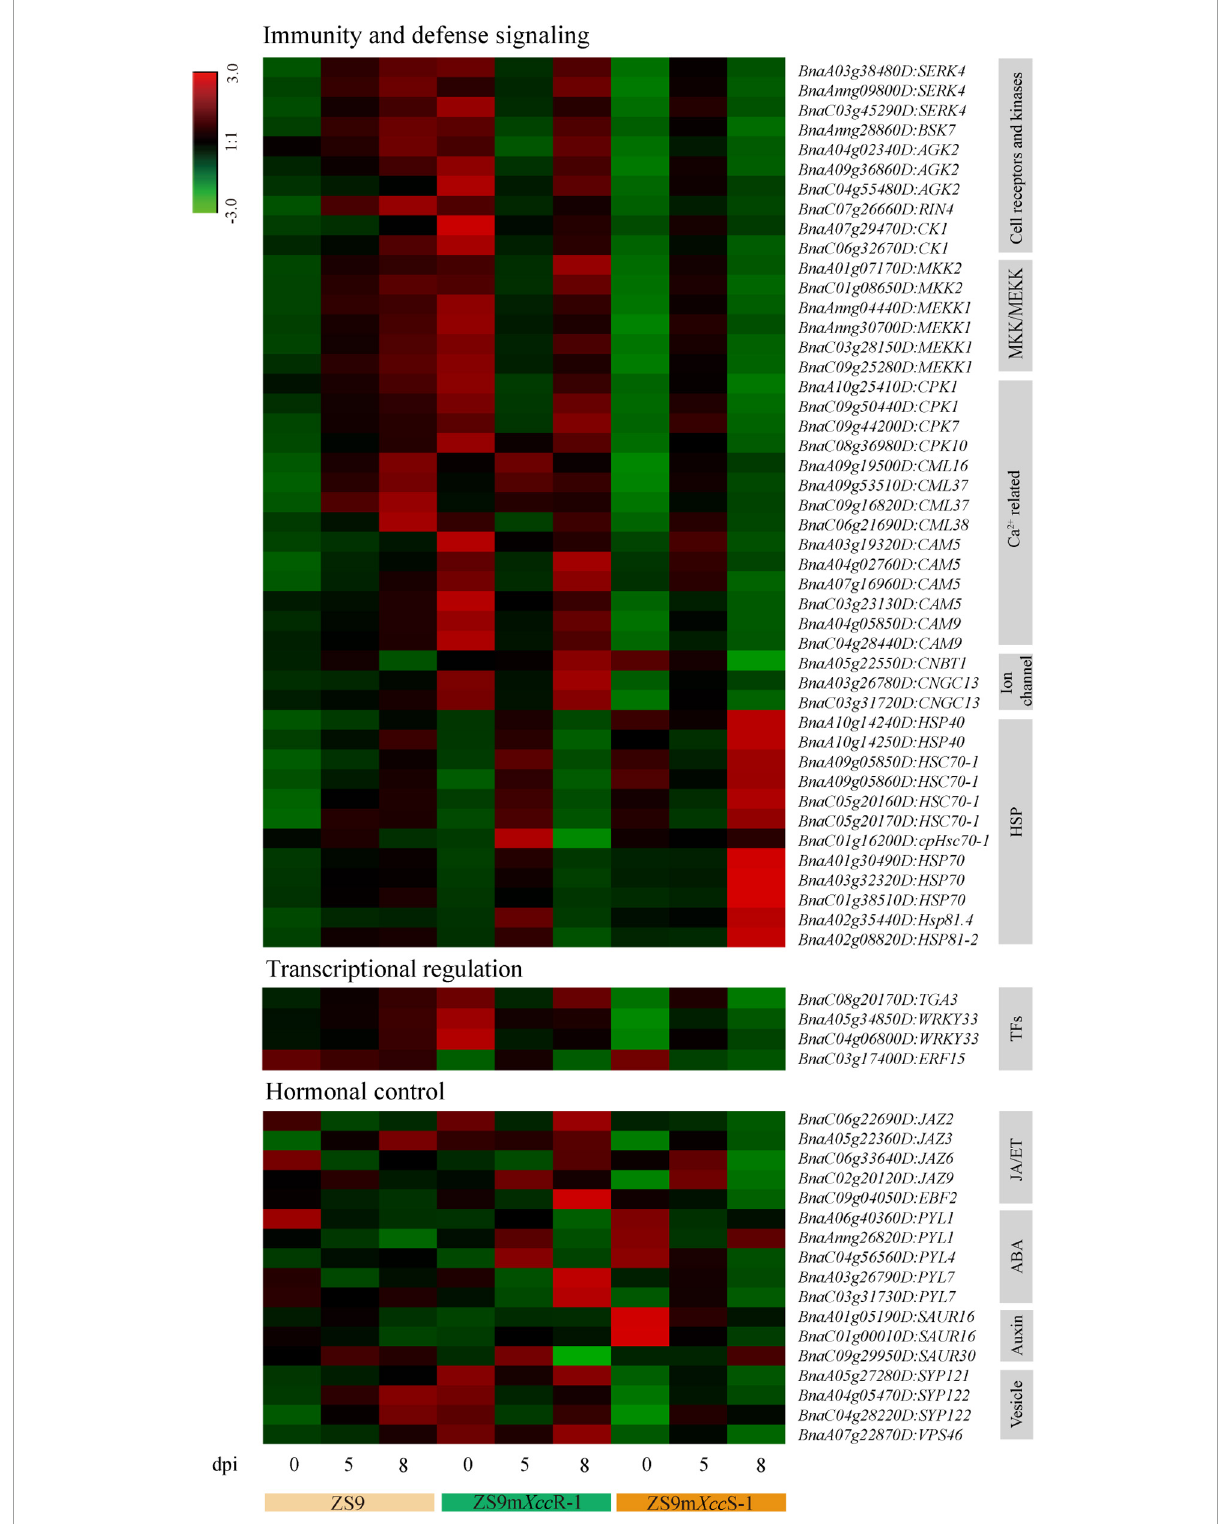
FIGURE7 Heat map visualization of selected DEGs related to immunity and defense signaling, transcriptional regulation, and hormonal control.